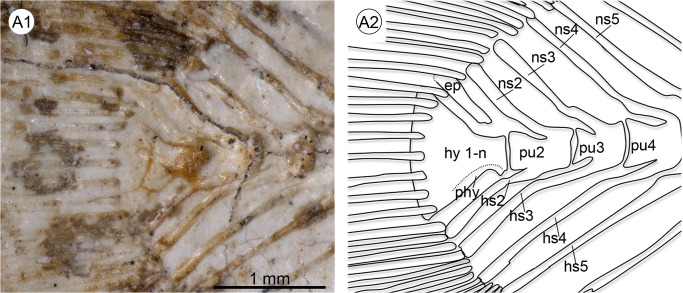
Details of the caudal skeleton of †K. kipkechi sp. nov. (paratype 1220´04).
A1–2 Caudal fin with overlap between the proximal part of the parhypural, the terminal centrum and the hypural plate, right lateral view. Abbreviations: ep, epural; hs2–5, haemal spine of preural vertebrae 2–5; hy 1–n, hypural plates 1–n; ns2–5, neural spine of preural vertebrae 2–5; phy, parhypural; pu2–4, preural vertebrae 2–4.